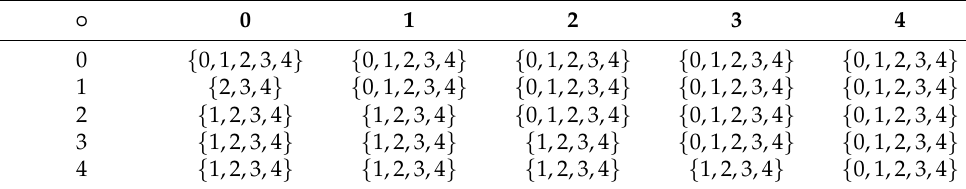
Table 6. Quasi-hyper BZ